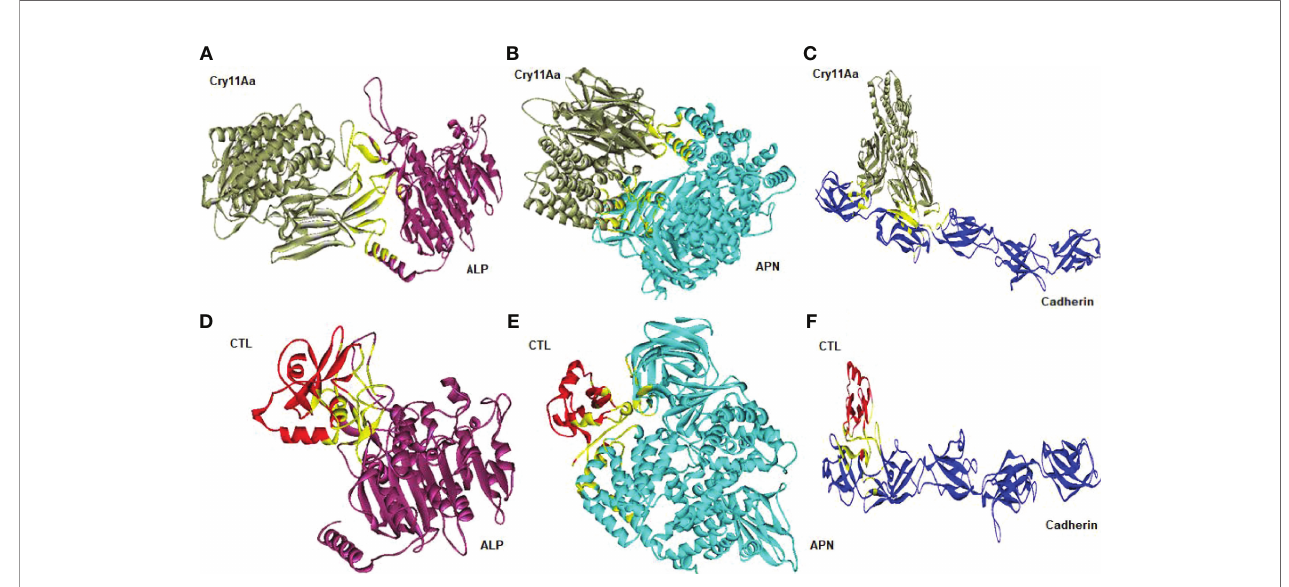
FIGURE 5 | Molecular docking representation of receptors with Cry11Aa and CTL proteins. Cry11Aa binding with (A) ALP, (B) APN, and (C) Cadherin receptors. CTL binding with (D) ALP, (E) APN, and (F) Cadherin receptors. Yellow color showed the binding sites of two